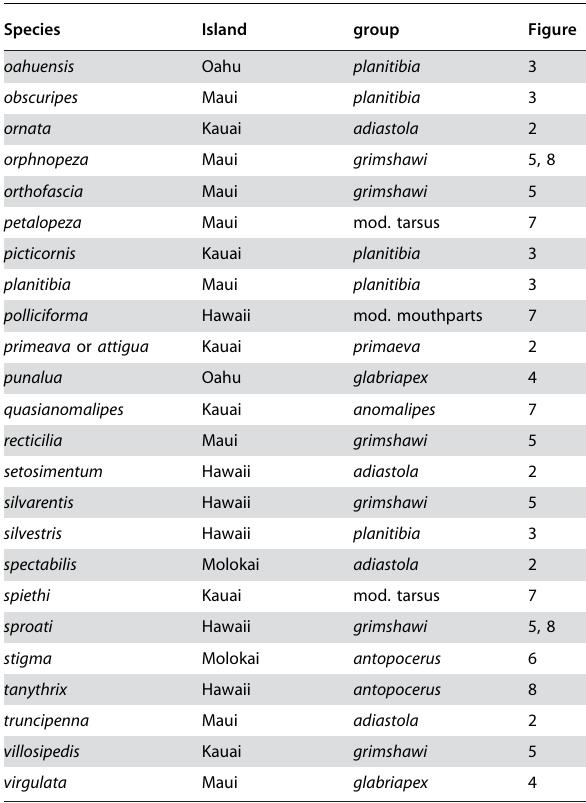
Table 1. Species in the Hawaiian Drosophila Wing Database .. ... .... ... ... .... ... ... .... ... ... .... ... ... .... ... ... .... ... ... ....